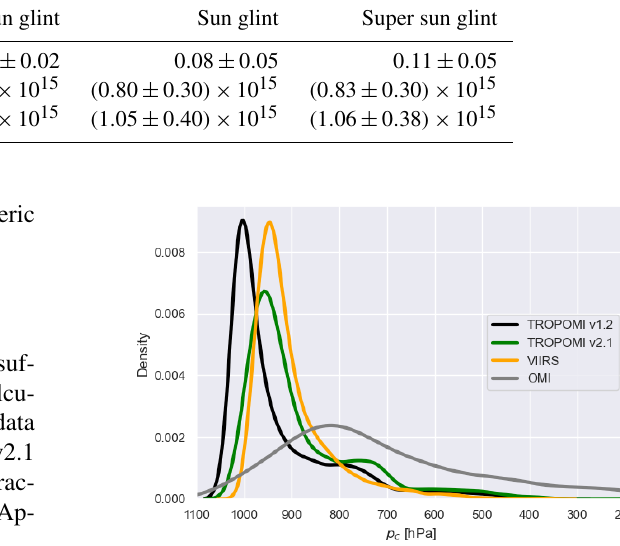
Figure 6. Probability distribution function of effective cloud pres- sures from TROPOMI v1.2, TROPOMI v2.1, OMI, and VIIRS for 1–6 July 2018 over the Bay of Biscay. Only cloud pressures for cloud fractions between 0.05 and 0.20 were selected as these are most relevant for AMF calculations for mostly clear-sky